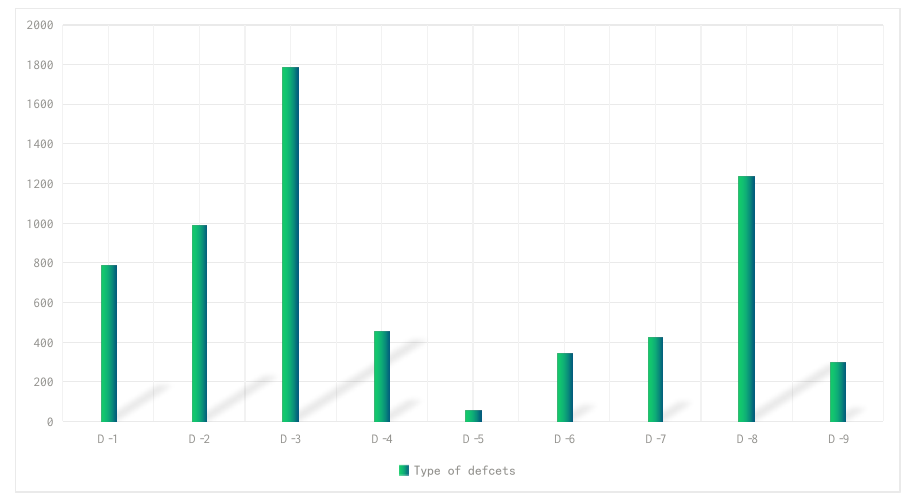
Figure 4. Sample distribution in WHD-9. Note: D-1 = block, D-2 = grinning, D-3 = oil pollution, D-4 = scratch,